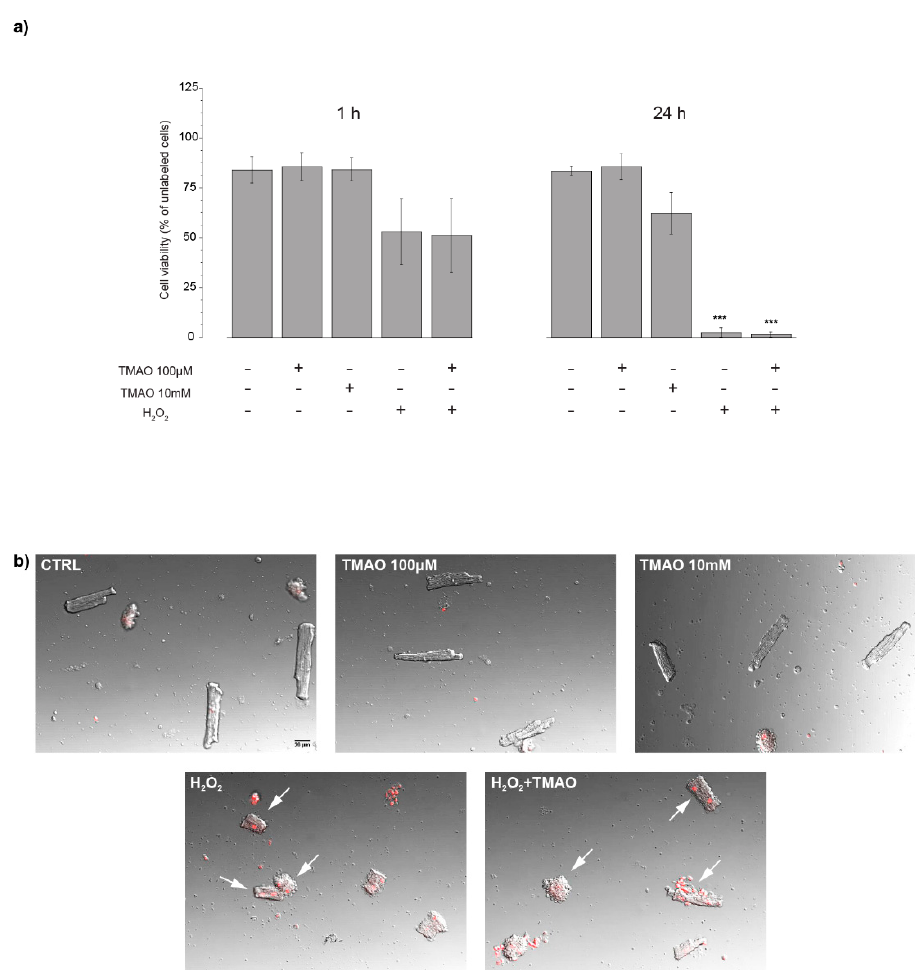
Figure 1. Cell viability after trimethylamine N-oxide (TMAO) exposure. ( a ) Bar graph of cell viability after 1 h and 24 h of treatment. Cell viability results reduced only after H 2 O 2 treatment for 24 h, condition not improved or worsened by the simultaneous treatment with TMAO (refer to the main text for numerical values). ( b ) Merged images in bright field and fluorescence of cells treated for 24 h with TMAO 100 µM and TMAO 10 mM, H 2 O 2 , and H 2 O 2 +TMAO and labeled with propidium iodide (PI) (20× magnification). White arrows point out PI-stained, damaged cardiomyocytes.